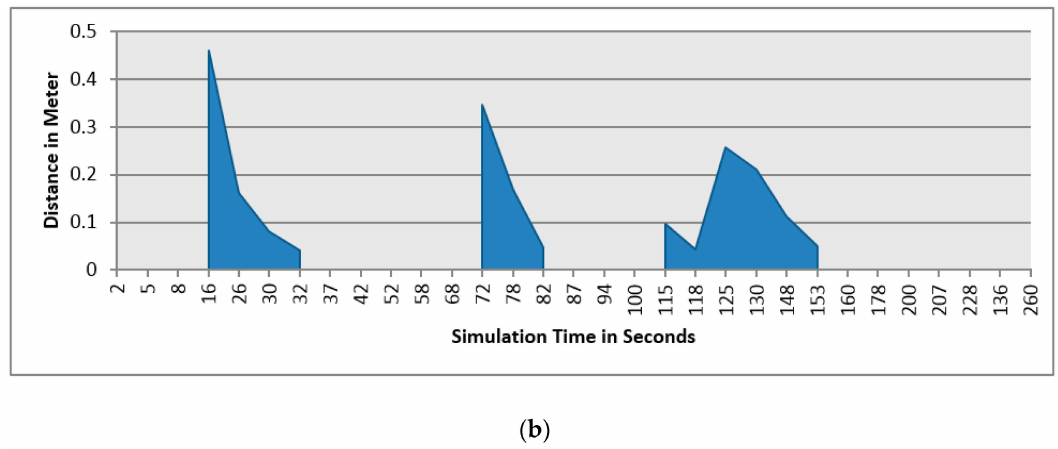
Figure 13. Distance to obstacles for both robots. ( a ) Distance to obstacles in meters for Robot 1; ( b ) Distance to obstacles in meters for Robot 2.